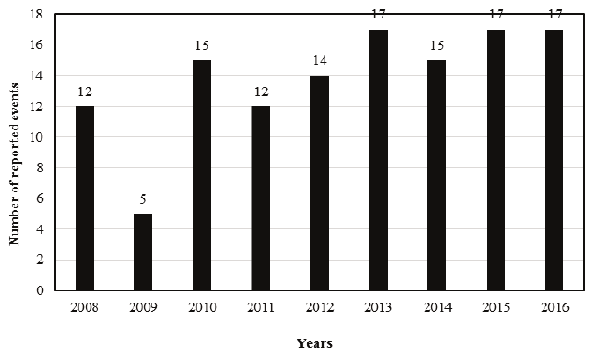
Fig. 24. Number of events caused by turbojet engines installed on Polish registered aircraft between 2008-2016